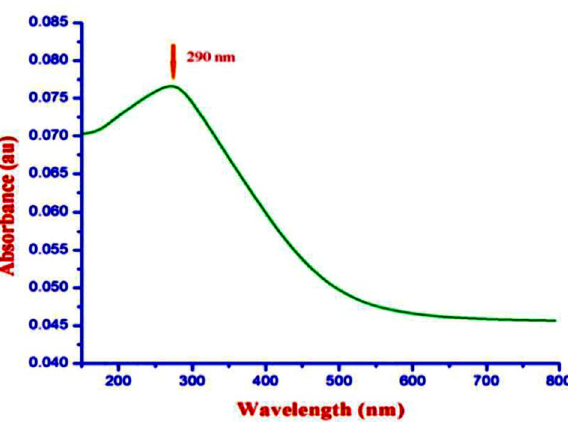
Figure 1. UV–vis- analysis of synthesized ZnO